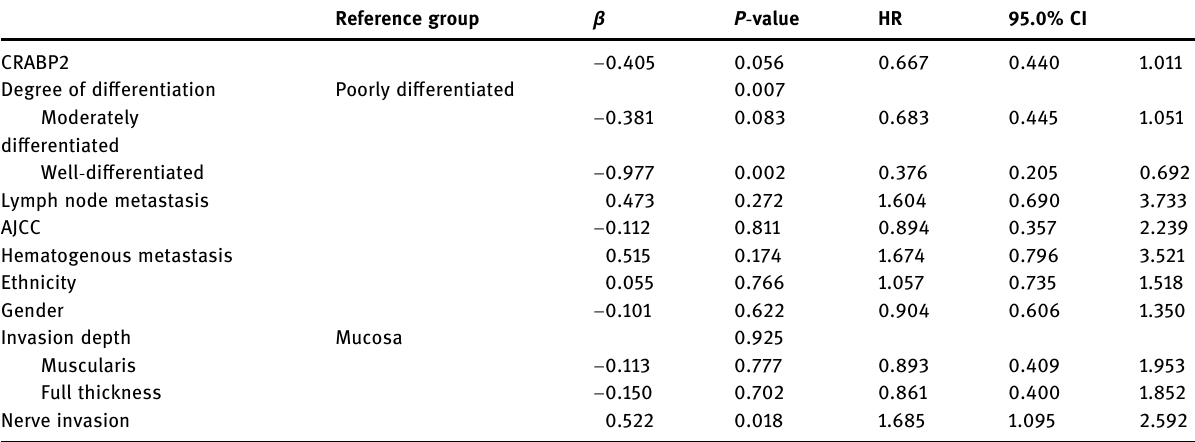
Table 6: Multivariate analysis of factors associated with OS for ESCC Reference group